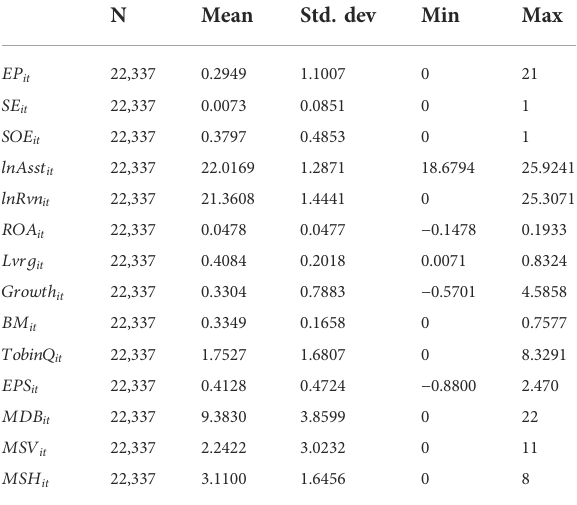
TABLE 1 Statistic summary.